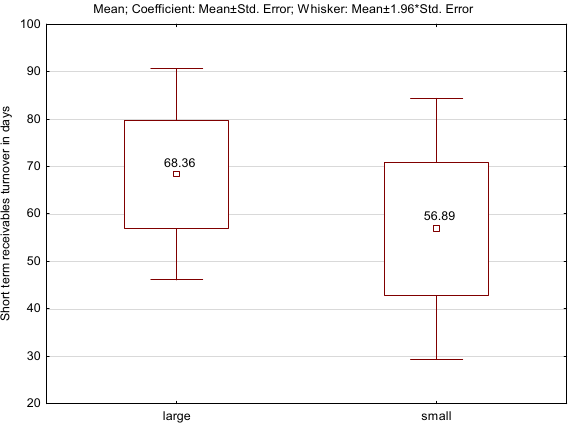
Figure 2. Rotation of short-term receivables in days in relation to the company’s size.